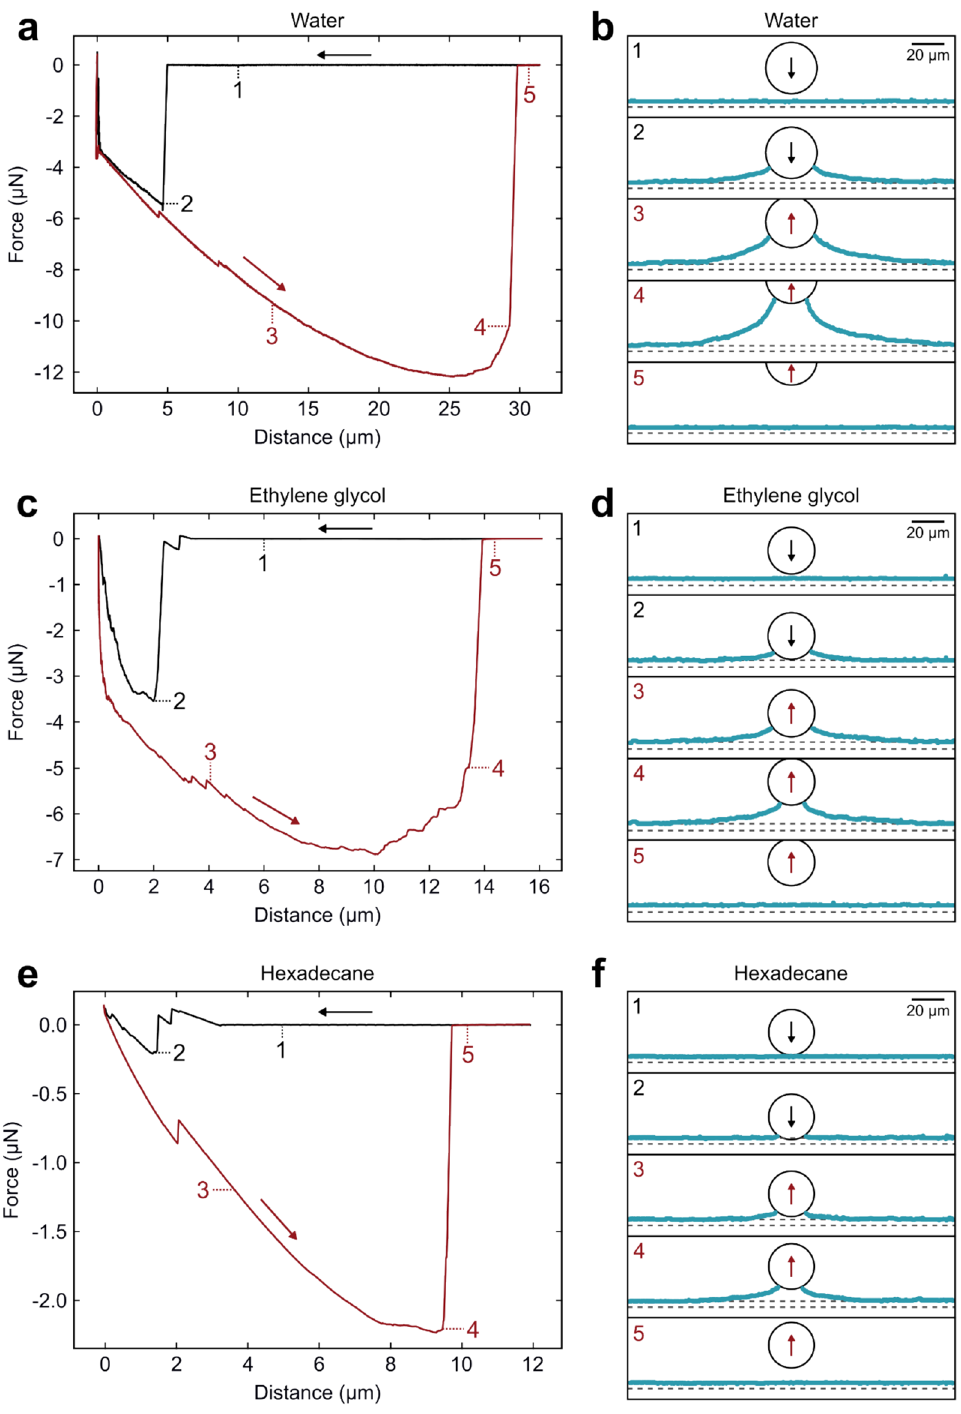
Figure 3. Representative force-distance curves (approach in black, retraction in red) with corresponding menisci shapes at the different positions (1–5) for measurements in ( a , b ) water, ( c , d ) ethylene glycol and ( e , f ) hexadecane. In ( b ), ( d ) and ( f ), the shape of the liquid–gas interface is plotted in cyan, the positions of the liquid–gas and glass-gas reflections as dashed lines and the particle position as a black circle. The piezo expansion rate was 0.2 µm s −1